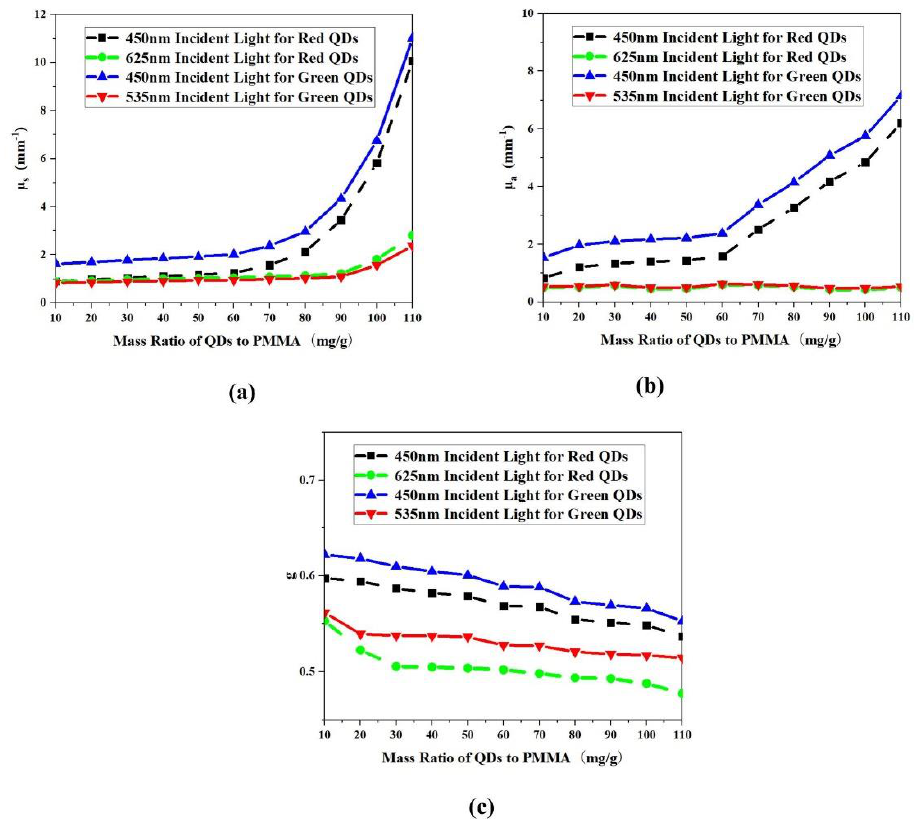
Figure 4. Calculated optical properties for red/green QDs samples with different mass ratio ( a ) the scattering coefficient μ s ; ( b ) the absorption coefficient μ a ; and ( c ) the anisotropy coefficient g .